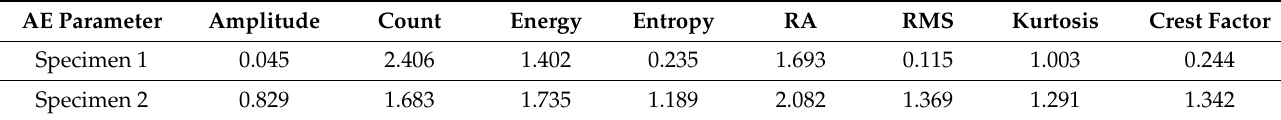
Table 2. Coefficients of Variance (CV) of different AE